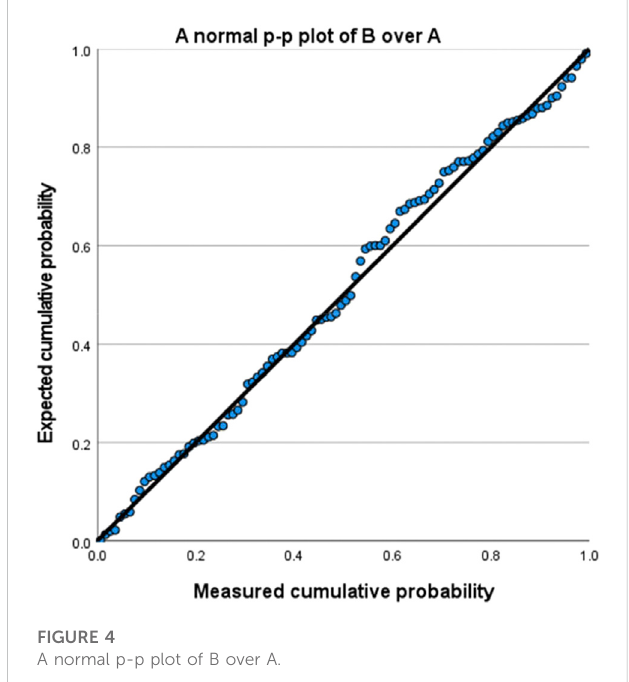
FIGURE 5 A normal p-p plot of C over